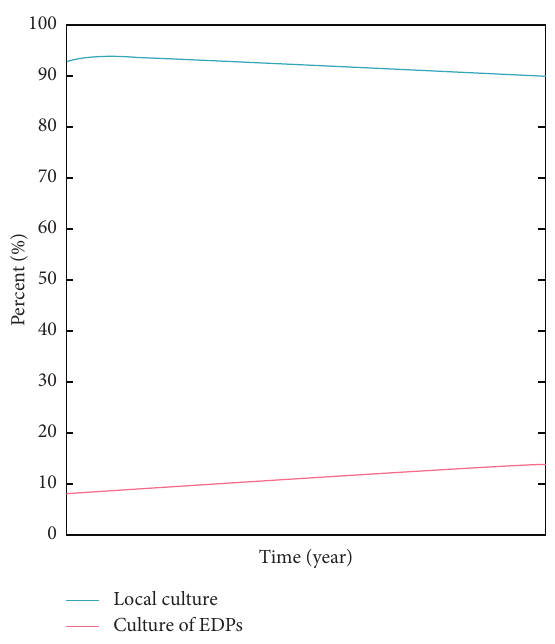
Figure 6: Population of culture over time in the case of policy